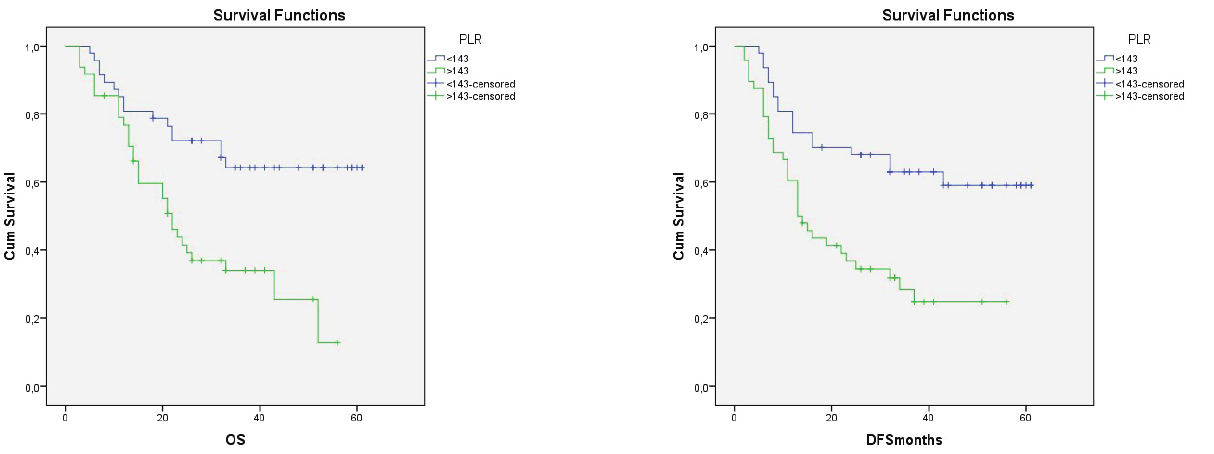
Figure 2b - Kaplan-meier curve for disease-free survival of low and high platelet / lymphocyte